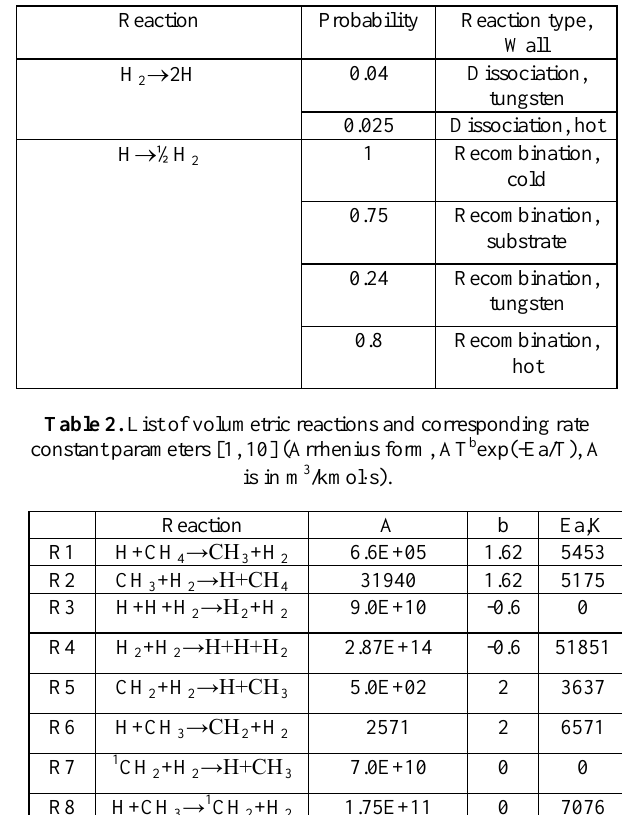
Figure 1. Computation domain with boundary conditions: 1 — inlet, 1.5 mm, 300 K, flow rates of H 2 and CH 4 are 1500 sccm and 15 sccm, respectively; 2 — cold, 10 mm, 300 K, 3 — hot, tungsten, 2400 K; 4 — hot, 2100 K; 5 — outlet, 1200 K; 6 — 24 mm, 1200 K; 7 — 10 mm; 8 — 18 mm, 1200 K; 9 — substrate, 8 mm, 1200 K; the axis of symmetry is at the bottom of the figure. Table 1. Probabilities of the surface reactions on different walls [1,10]